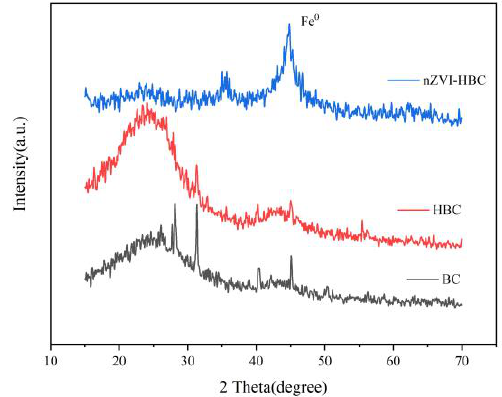
Figure 2. X-ray diffraction patterns of biochar.